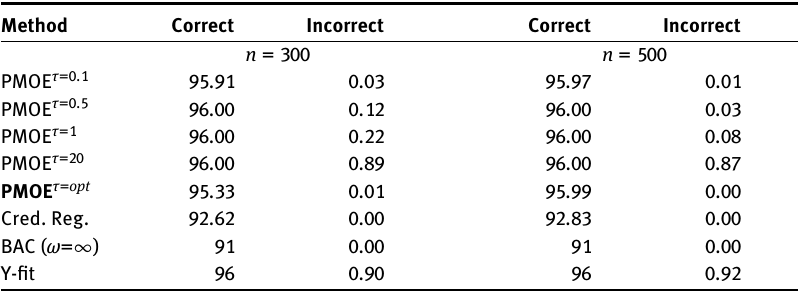
Table 2: Simulation results for scenario